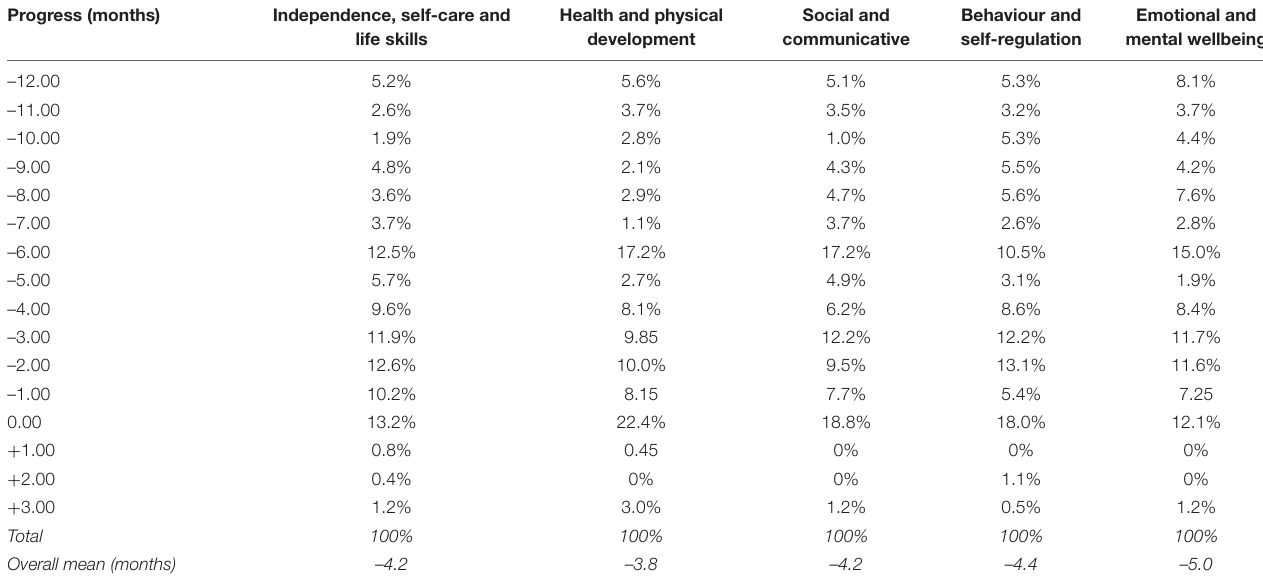
TABLE 2 | Average estimates on wider progress (May